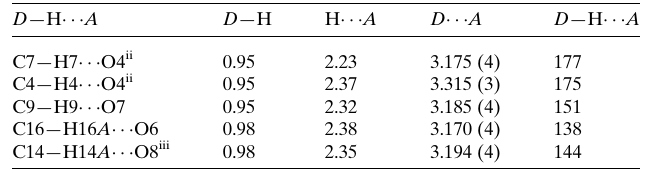
Table 1 Selected geometric parameters (A˚ , (cid:4) ).